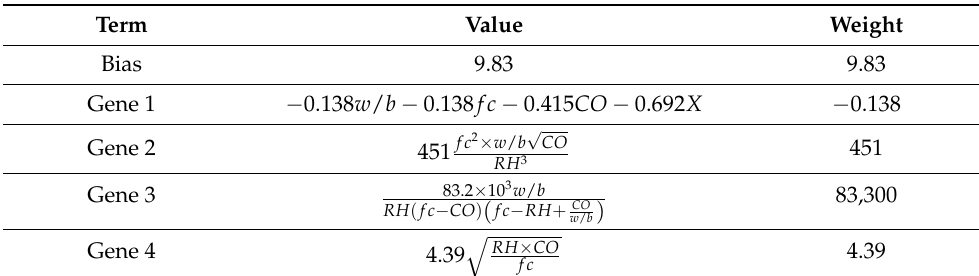
Figure 6. Expressional tree for MGGP approach. Table 3. Equations and weights for each